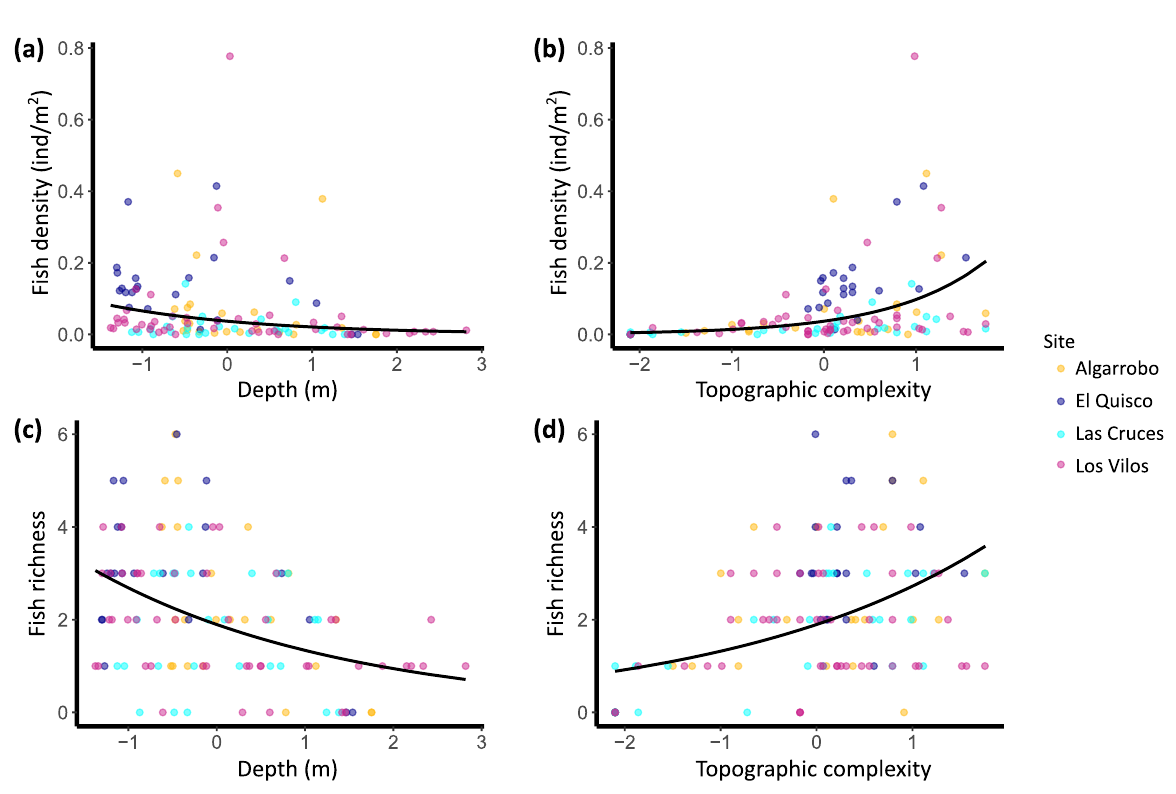
Figure 2. Conditional curves depicting the predicted fish density ( a , b ) and richness ( c , d ) by the GLMM and actual values (coloured dots). Depth and topographic complexity were standardised to have zero mean and unit standard deviation. Covariables not represented in each graph (fixed and random effects) were held at zero in the predictions. For fish density ( a , b ), the transect surface is held at 194.54 m 2 (offset mean), and fish density is obtained by dividing predicted fish abundance by 194.54. GLMM for fish richness does not include offset. N =